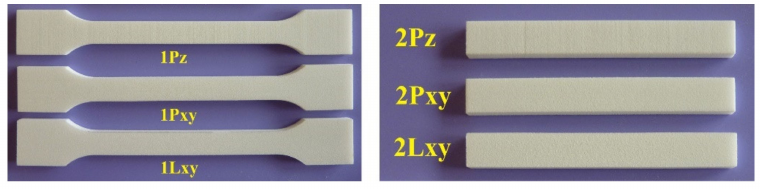
Figure 1. Test specimen manufactured by SLS